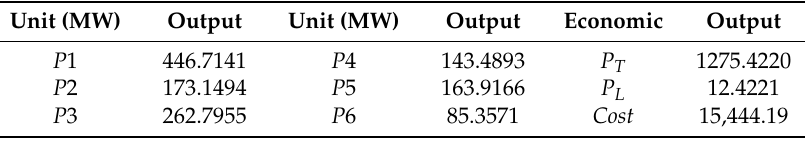
Table 11. Best solution achieved by ML-CLPSO-AM on a 6-unit system.